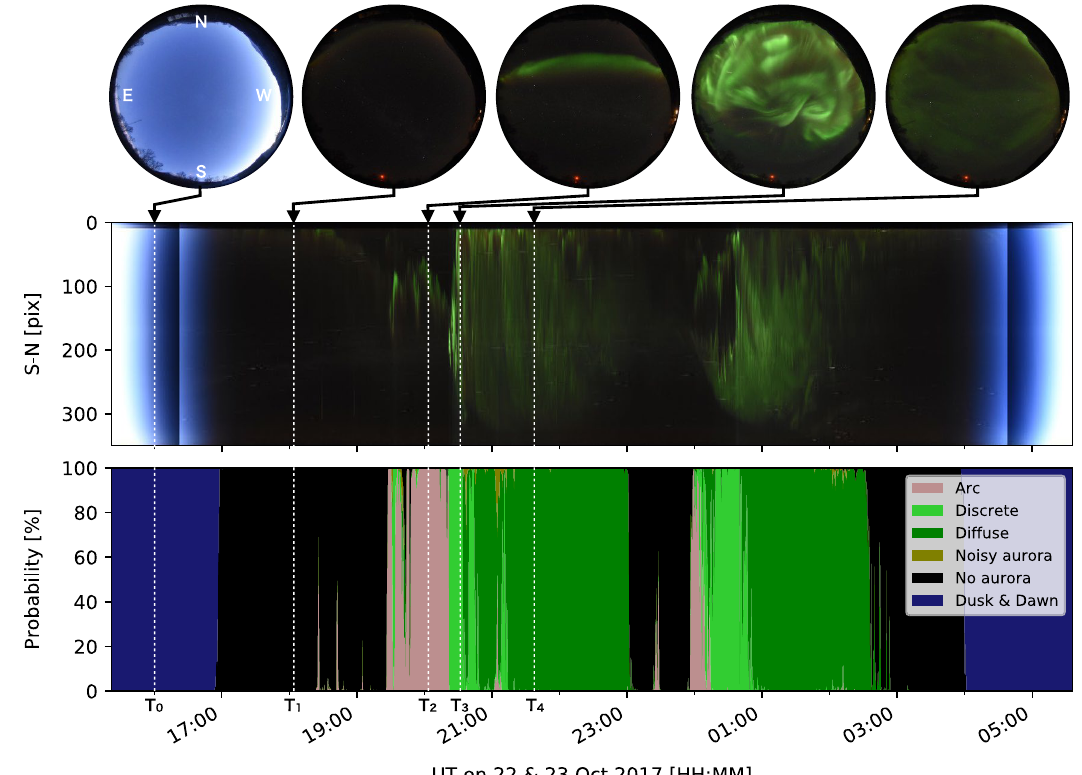
Figure 3. Observation and classification results from the night of 22–23 October 2017. The middle panel shows a keogram, which is a time series of the north-south cross-section of the all-sky image, and the bottom panel is the classification result for the same period. All-sky images at certain specific times ( T 0 to T 4 ) are displayed on the top. T 0 to T 4 are 16:00:01, 18:00:05, 20:04:39, 20:30:40, and 21:30:11 UT, respectively. From 19:30 to 23:00 UT, the typical substorm, characterized by a sequential appearance of Arc , Discrete , and Diffuse , was almost perfectly classified. A similar substorm occurred again from midnight and was also classified indicating that the level of local geomagnetic disturbance and automatically derived auroral occurrence rate are positively correlated over a long period of 10 years. Figure 6 shows the monthly variation of the auroral occurrence rate shown in Fig. 4. The blue line covers all UT, while the red line covers only 19–02 UT, i.e., the time when the sky is completely dark from September to March. The occurrence rate of the red line, which is for limited UT periods, is higher than that in the blue line, suggesting that the auroral occurrence rate is lower in the early and later UT. In both the lines, the auroral occurrence rate attains its maximums in October and February and a minimum in December. This means that regardless of the length of the dark hours, the occurrence of auroras is higher in autumn and spring and lower in winter. Especially, the blue line shows a difference of nearly two-fold between the auroral occurrence rates in October and December. It has been pointed out since the beginning of the 20th century that the frequency of magnetic storms is higher near the spring and autumnal equinoxes, and lower around the summer and winter solstices 25 . This effect is often interpreted using the misalignment of the Earth’s rotation and magnetic axes and the 30-day periodicity of the spiral structure of the solar wind, and is well known as the Russell–McPherron (R–M) effect 26 . The monthly variation of the auroral occurrence rate is qualitatively consistent with the charac- teristics of the R–M effect. Figure 7 shows the UT distribution of the Observable classes obtained over a period of 10 years. Panel ( a ) shows the number of images, panel ( b ) shows the composition ratio of panel ( a ) for each UT bin, and panels ( c )–( e ) show the values of panel ( b ) for each Auroral class. In panel ( a ), while more than 25000 images were stably classified as Observable in 19–02 UT, the number of the images increased/decreased in 15–18/03–06 UT, respectively. This is due to the monthly change in the length of the dark time. To reduce this effect, the composi- tion ratio of each class in each UT bin is shown in panel ( b ). The lower ratio of the Auroral classes to the Clear class in the early and late UT was consistent with the suggestion from Fig. 6 that auroras occur less frequently in these UT periods. The ratio of the Auroral classes reached its maximum at 22 UT, which roughly corresponds to 01 MLT. This result is consistent with the results of previous studies obtained by visual detection 9–11 . Panel ( b ) shows that discrete auroras are dominant in the evening hours and diffuse auroras are dominant from the magnetic midnight (00 MLT ∼ 21 UT) to the morning. The comparison of panels ( c ) and ( d ) shows that the ratio of Arc is higher than that of Discrete in 15–18 UT, which may be due to the tendency that intense discrete auroras occur after the appearance of an arc-type aurora 23 , as seen in Fig. 3. The Discrete auroras had a wide plateau at 18–21 UT ( ∼ 21–00 MLT). By contrast, the ratio of Diffuse auroras gradually increased from the evening hours,